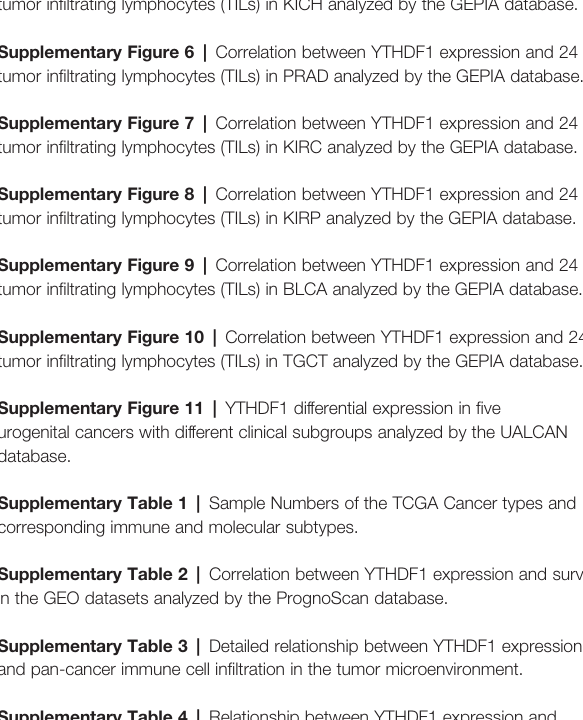
Supplementary Figure 3 | Relationship between YTHDF1 expression and pan- cancer immune subtypes. Supplementary Figure 4 | Relationship between YTHDF1 expression and pan- cancer molecular subtypes.